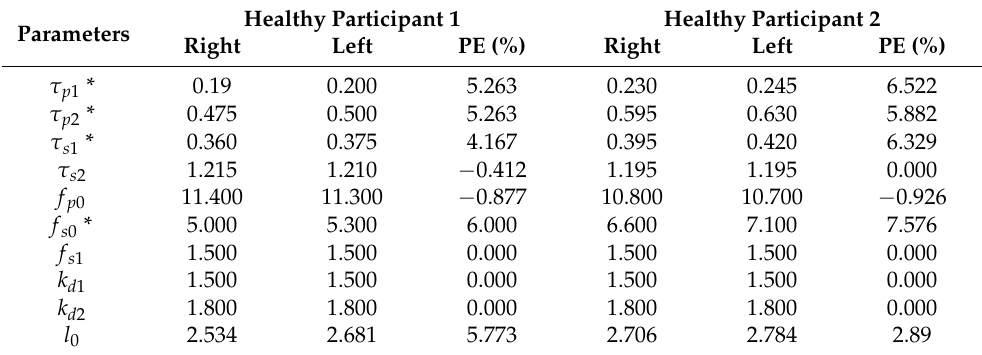
Table 5. Percentage error of 10 parameters between stimulated eye (right eye) and non-stimulated eye (left eye) in two participants.